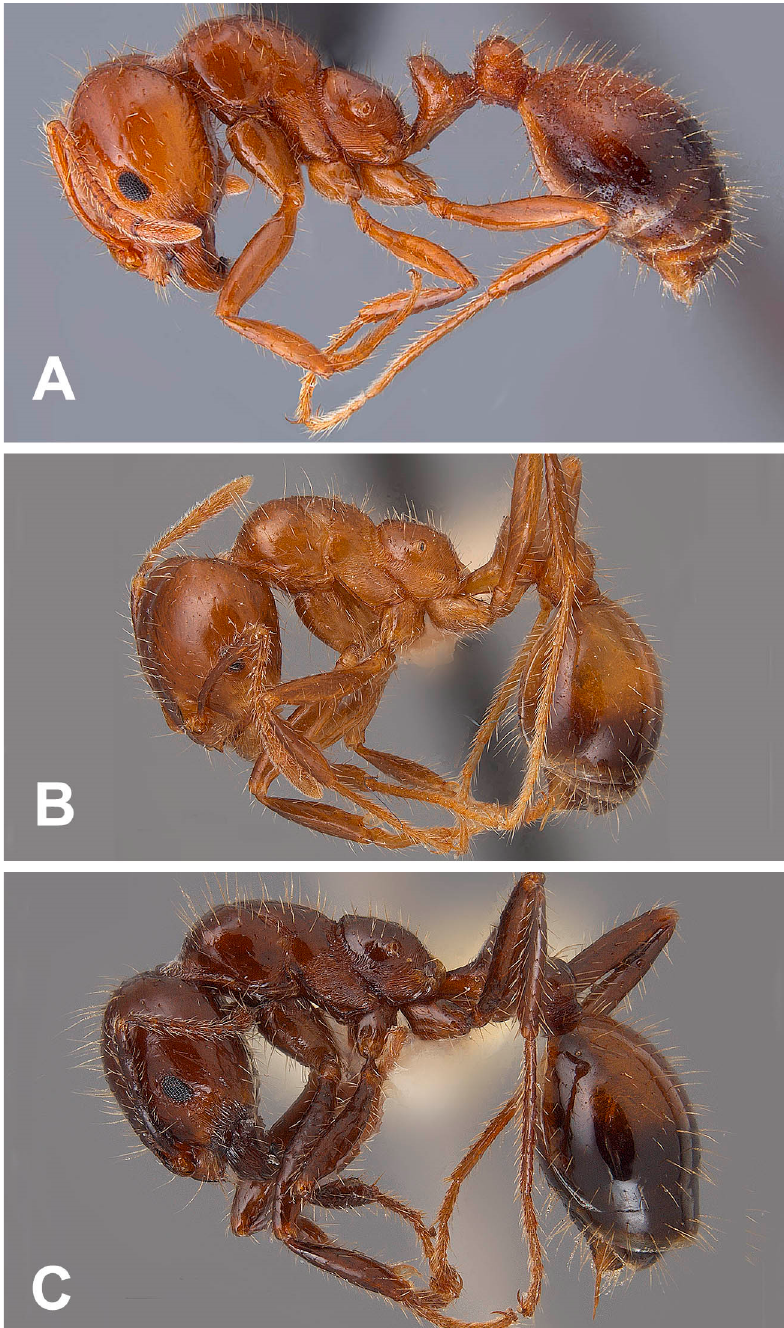
Figure 1. Lateral habitus views of imported fire ant workers: ( A ) Solenopsis invicta , ( B ) S. invicta X richteri , and ( C ) S. richteri .